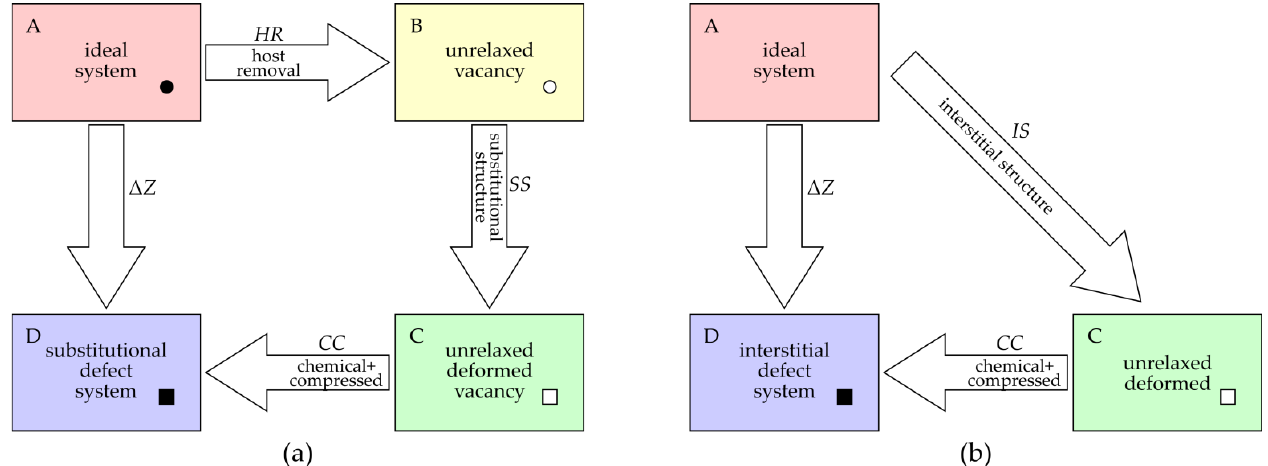
Figure 1. Schematic representation of influence of the substitutional ( a ) and interstitial ( b ) defect on a physical quantity Z . System A and D are fully relaxed ideal and defect supercells; B is created by substituting a host atom in A (black circle) with vacancies (white circle) without further relaxation; C is created by substituting an impurity atom in D (black square) with vacancies (white square) without further relaxation.